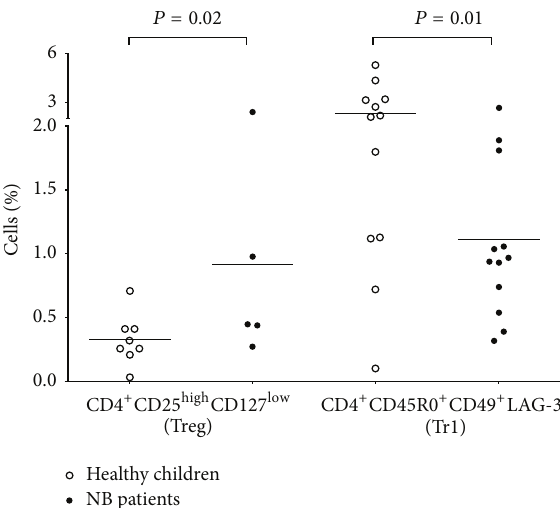
Figure 5: Percentages of Treg and Tr1 cells in PB samples from healthy children (empty circles) and children with metastatic NB (black circles). Data are expressed as % of total cells. Horizontal bars indicated means. 𝑃 values are indicated where differences are